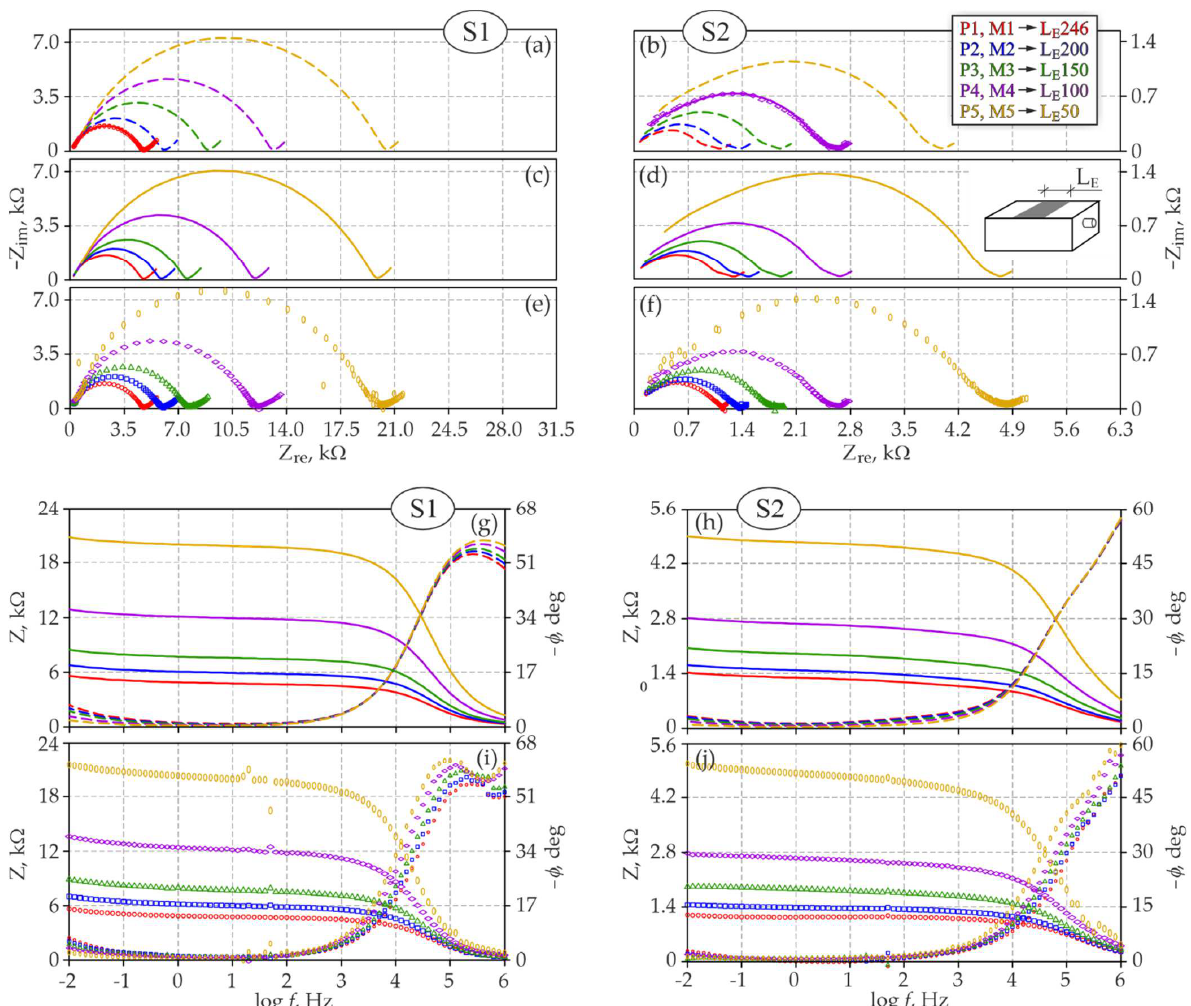
Figure 6. Comparison of model simulations and test results concerning the impact of the counter electrode length on the shapes of impedance spectra of steel in S1 and S2 concrete: ( a ) and ( b ) model spectra obtained on the Nyquist plot from initial spectra based on the 3D model , ( c ) and ( d ) adjusted model spectra on the Nyquist plot that included moisture content in concrete, ( e ) and ( f ) experimental spectra on the Nyquist plot, ( g ) and ( h ) model spectra on the Bode plot with an included effect of moisture content in concrete, ( i ) and ( j ) experimental spectra on the Bode plot.